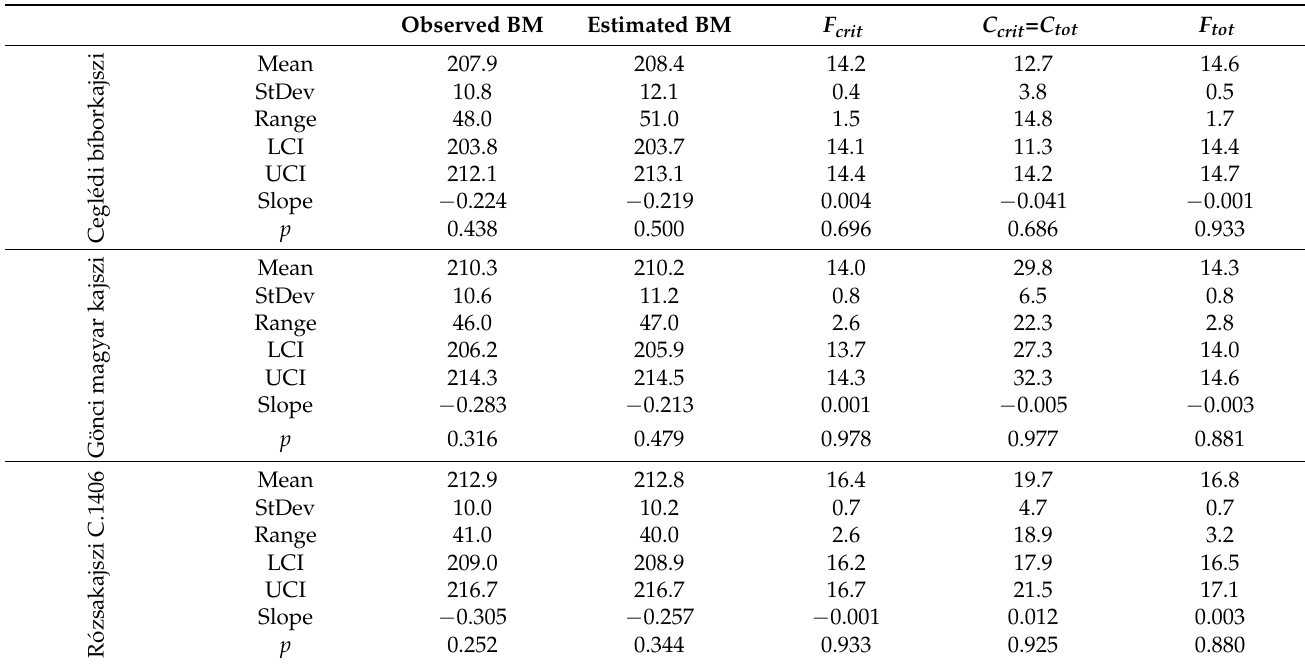
Table 5. The mean, standard deviation (StDev), range, lower and upper 95% confidence limits (LCI, UCI) of the observed and estimated blooming start (BM), and the parameters of the unified model F crit , C crit = C tot , and F tot , together with their slope in the measured 26 years (1994–2020) with their corresponding significance levels ( p )of the varieties ‘Cegl é di b í borkajszi’, ‘Gönci magyar kajszi’, and ‘R ó zsakajszi